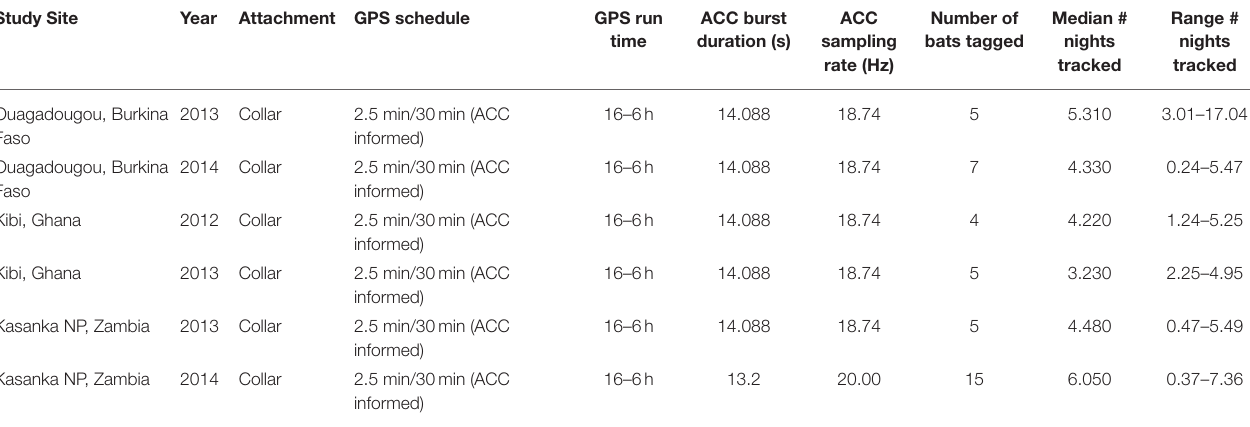
TABLE 1 | Deployment information for GPS + ACC loggers on E. helvum . Study Site